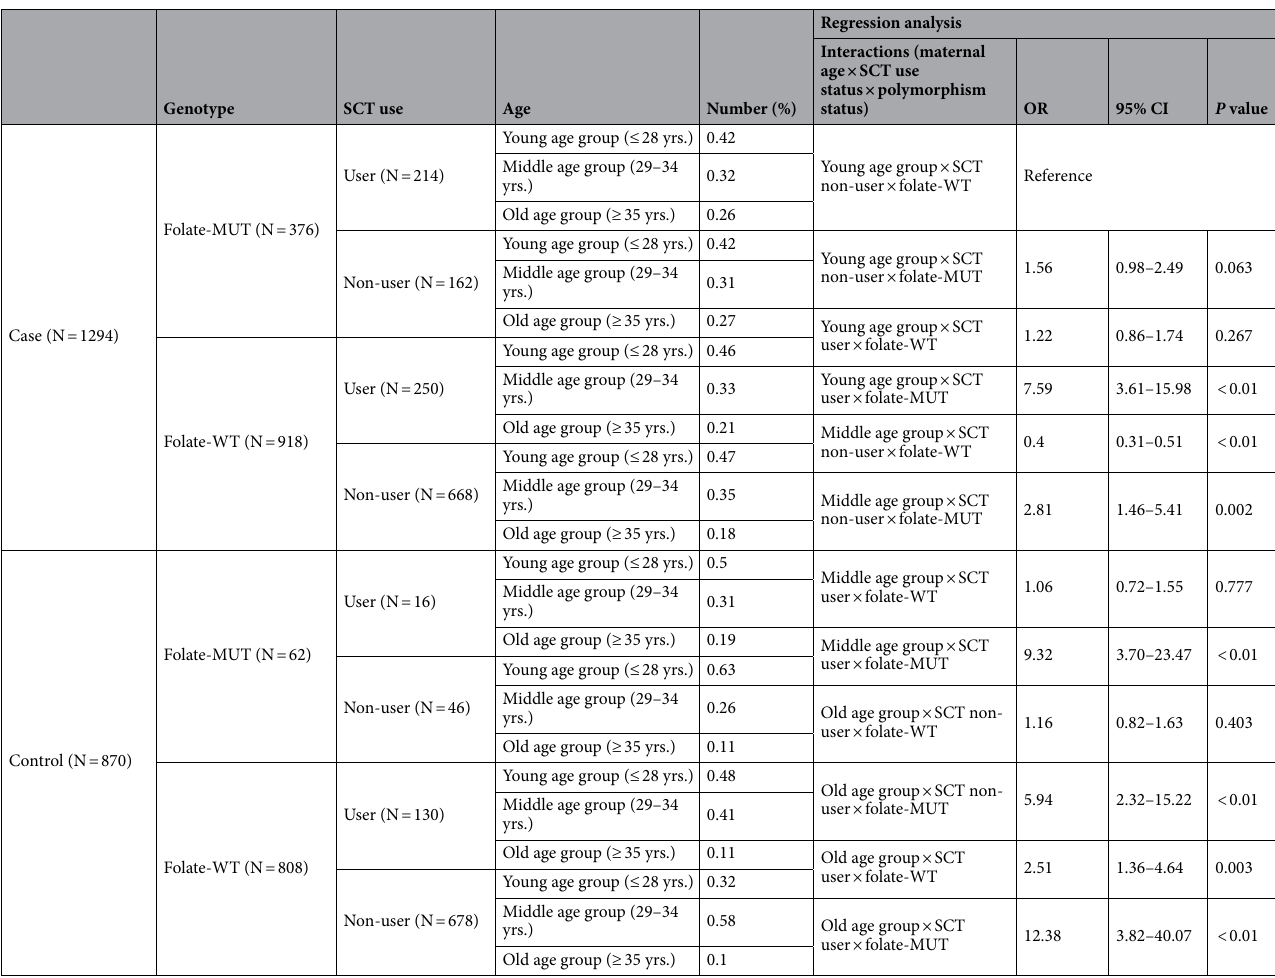
Table 3. Distribution of case–control women stratified by folate regulator genotype, SCT use status and maternal age at conception show interactions among various risk factors and their association with case and control women. Binary logistic regression analysis was performed considering maternal age, SCT use status and Folate regulator genotype as predictor variable and DS risk as outcome variable to find out the association of genotype with case and control and P value < 0.05 is considered statistically significant. N number of individuals, OR odd ratio, CI confidence interval, Folate-WT folate wild-type genotype, Folate-MUT folate polymorphic/mutant risk